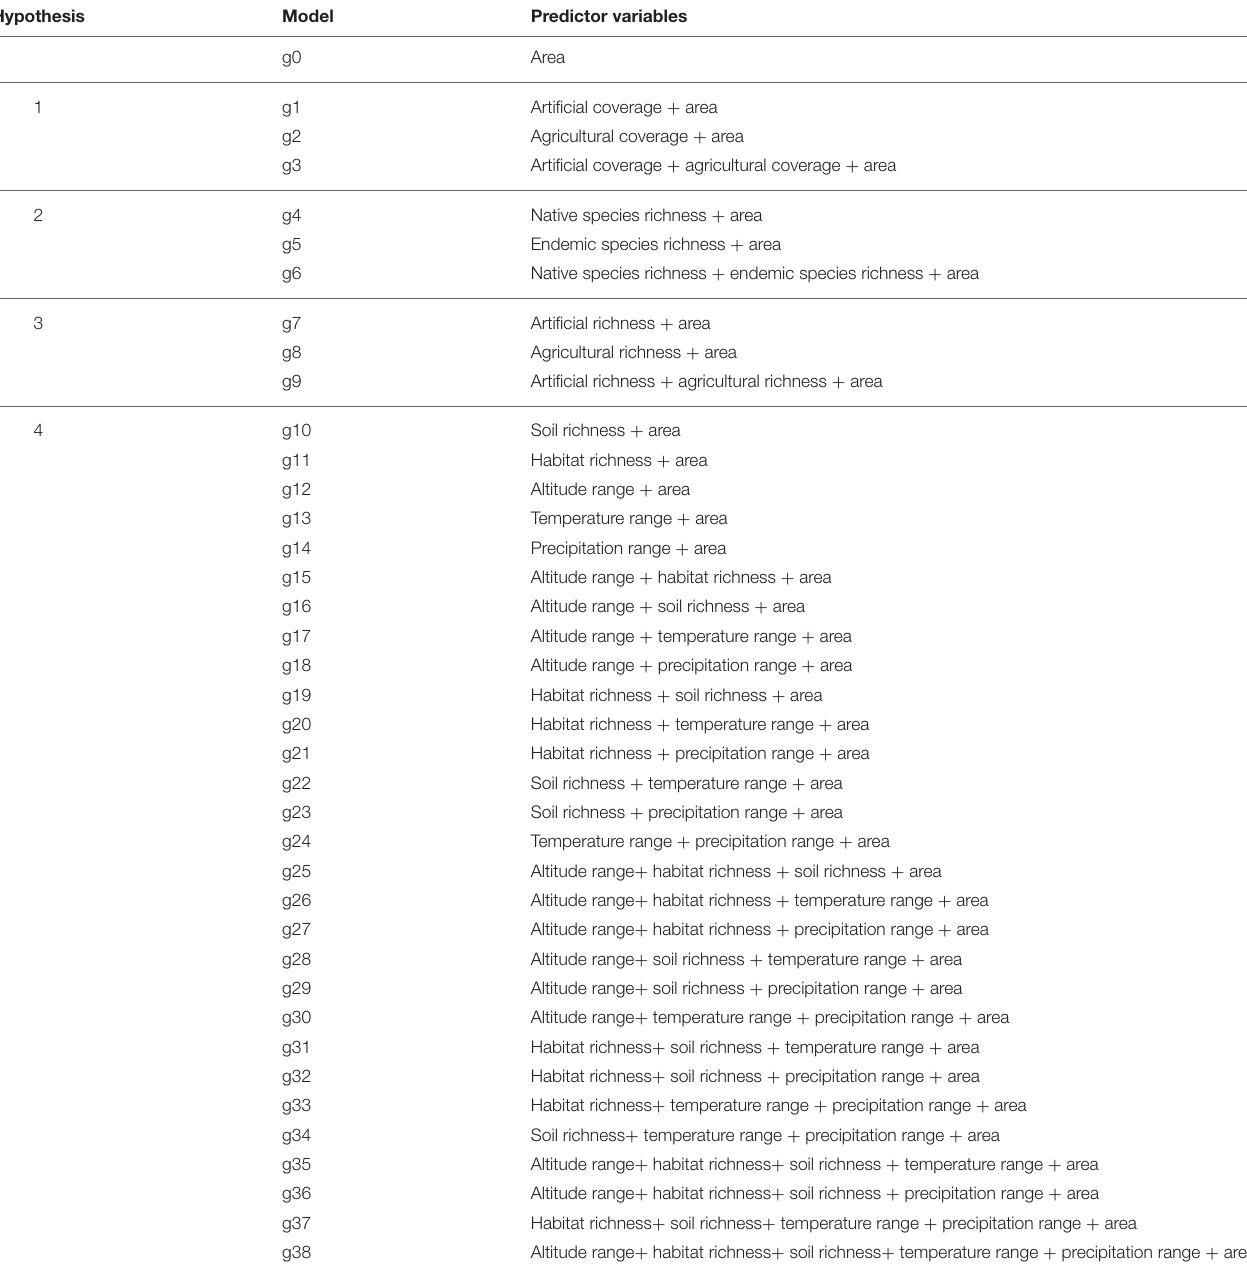
TABLE 1 | List of all models and predictor covariates of alien species richness related to each of the four hypotheses. Hypothesis Model Predictor